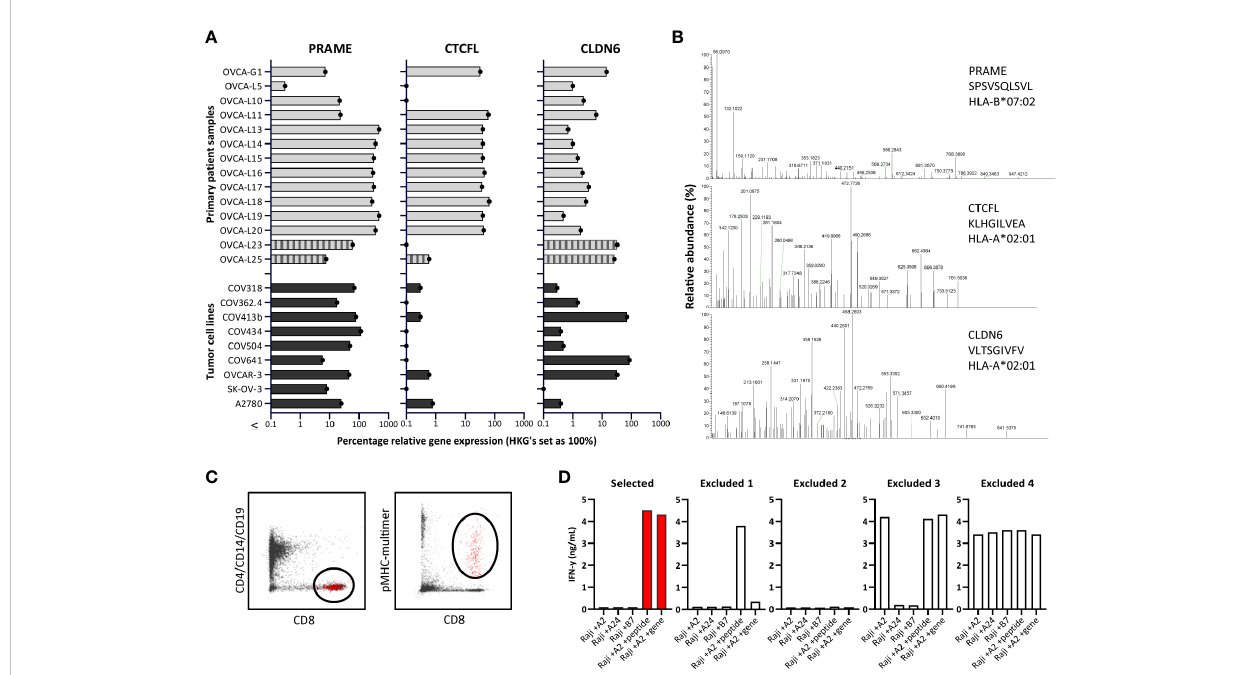
FIGURE 2 Identi fi cation of PRAME, CTCFL and CLDN6 peptides and T-cell clones. (A) PRAME, CTCFL (TvX) and CLDN6 mRNA gene expression in 14 OVCA patient samples (12 solid tumor tissues and 2 malignant ascites samples (OVCA-L23 and OVCA-L25)), and 9 OVCA cell lines. Expression was measured by qPCR and is shown as percentage relative to the three HKGs GUSB , VPS29 and PSMB4 , which was set at 100%. (B) Example of three OVCA-derived peptides identi fi ed in our HLA ligandome analyses. Shown are the mass spectra of the eluted peptides, including the gene, peptide sequence and HLA restriction. All eluted peptides were validated by comparing tandem mass spectra of eluted peptides and synthetic peptides, as shown in Supplementary Figure 3. (C) Representative fl ow cytometry plots of the pMHC-multimer enriched cell population in 1 of the 25 healthy donors. Shown is the gating strategy of the single-cell sorted population (depicted in red), gated on CD8 (Alx700) +, pMHC-multimer (PE) + and CD4/CD14/CD19 (FITC) -. (D) Examples of recognition patterns based on IFN- g production (ng/mL) of selected and excluded T-cell clones during the fi rst T-cell screenings. T-cell clones were cocultured with Raji cells transduced with various HLA alleles, combined with loading of OVCA peptides (1 m M) or transduction of OVCA genes (E:T=1:6). Excluded 1 – 4 represent T-cell clones lacking potency and/or speci fi city. (HKGs, housekeeping genes; OVCA, primary ovarian cancer